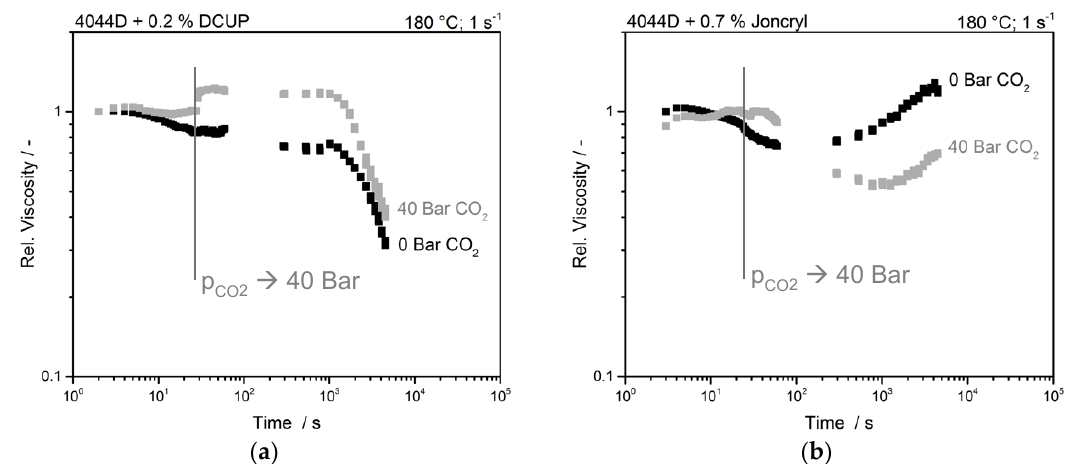
Figure 5. Time sweep of ( a ) peroxide modified and ( b ) chain extender modified PLA with and without the presence of CO 2 .